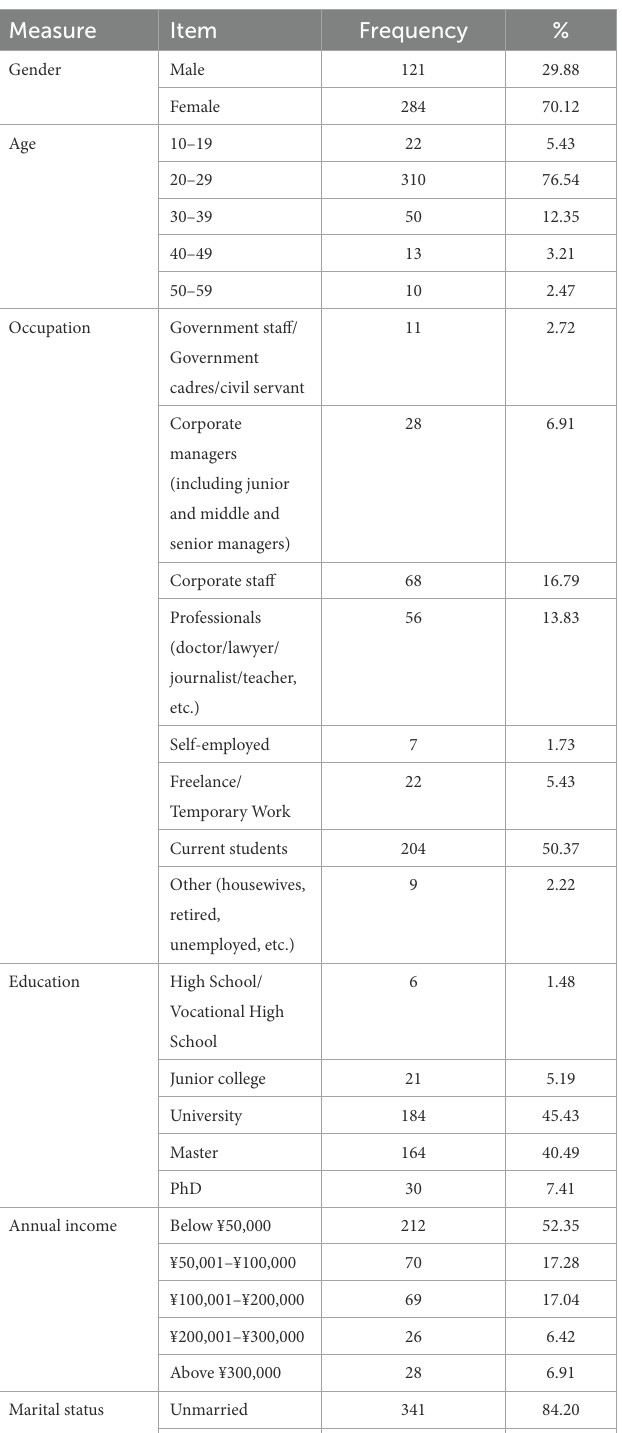
TABLE 1 Subject’s demographic and usage